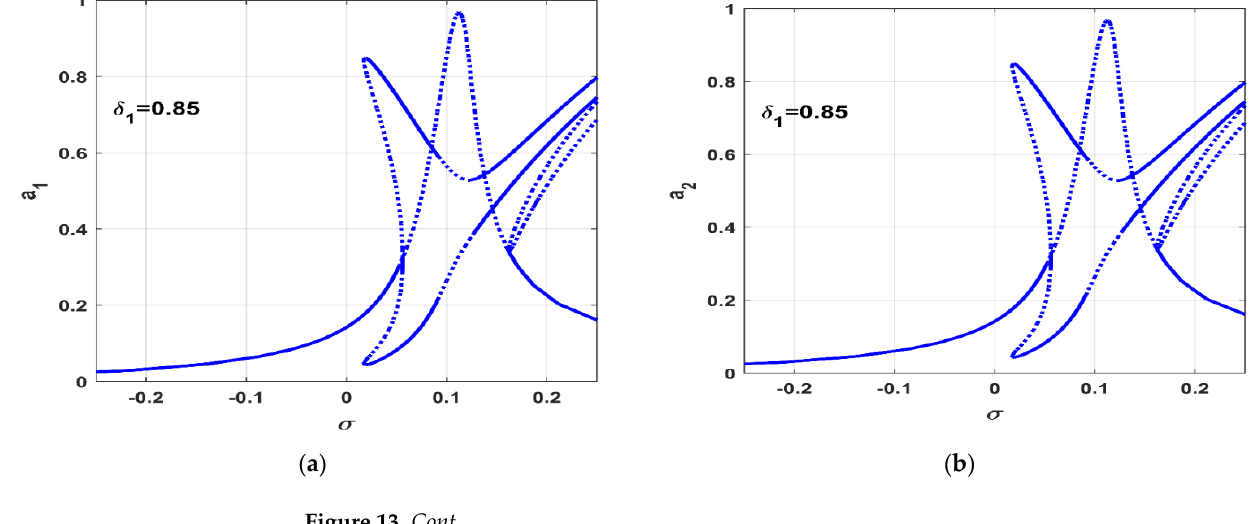
( d ) Figure 13. 𝜎 − response curve of the controlled Jeffcott rotor (i.e., 𝐸 = 0.03,𝜆 = 0.05 , and 𝛿 (cid:2870) = 0.002 ) at two different value of the proportional gain 𝛿 (cid:2869) : ( a , b ) oscillation amplitudes ( 𝑎 (cid:2869) and 𝑎 (cid:2870) ) versus 𝜎 when 𝛿 (cid:2869) = 0.85 , and ( c , d ) oscillation amplitudes ( 𝑎 (cid:2869) and 𝑎 (cid:2870) ) versus 𝜎 when 𝛿 (cid:2869) = 0.8 . To validate the accuracy of the Figure 13, the system equations of motion (i.e., Equa- tions (20) and (21)) have been solved numerically using ODE45 according to Figure 13 (i.e., when 𝐸 = 0.03, 𝛿 (cid:2870) = 0.002 ) at 𝜎 = 0.1 and 𝛿 (cid:2869) = 0.85 , 0.8 as shown in Figure 14. The figure has been obtained via simulating Equations (20) and (21) by letting 𝛿 (cid:2869) = 0.85 along the time interval 0 ≤ 𝑡 ≤ 700 , where at instant 𝑡 = 700 , the control parameter 𝛿 (cid:2869) has been decreased to 0.8 on the interval 700 < 𝑡 ≤ 1000 . It is clear from Figure 14 that the Jeffcott system exhibits a quasi-periodic motion (i.e., unstable periodic solution) when 𝛿 (cid:2869) = 0.85 and 𝜎 = 0.1 on the time interval 0 ≤ 𝑡 ≤ 700 , but when 𝛿 (cid:2869) has been de- creased to 0.8 , the unstable periodic solution has been turned into a stable periodic solu- tion on interval 700 < 𝑡 ≤ 1000 . Comparing Figure 14 with Figure 13 at 𝜎 = 0.1 , one can demonstrate the excellent correspondence between the analytical results given in Figure 13 and the numerical simulations shown in Figure 14.